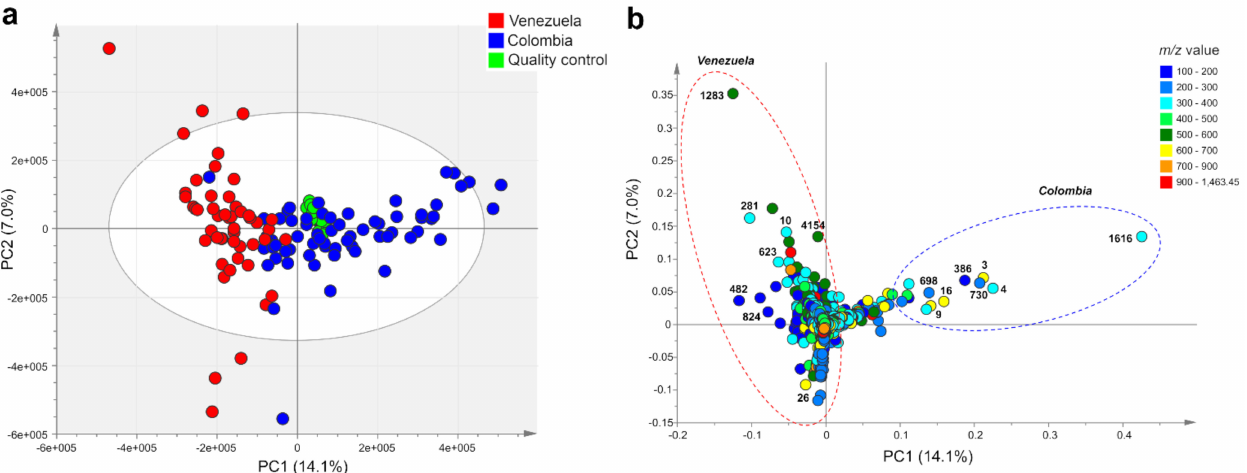
Figure 2. Principal component analysis (PCA) based on metabolic fingerprinting in negative ion mode of 113 taxa of Espeletiinae (representing 210 samples and 4181 variables). ( a ) Scores plot showing the clustering of samples according to their country of origin (Venezuelan samples in red and Colombian in blue) and ( b ) loadings plot. Discriminant mass signals in the loadings plot are labeled according to their MZmine IDs. For compound identities, please refer to Table